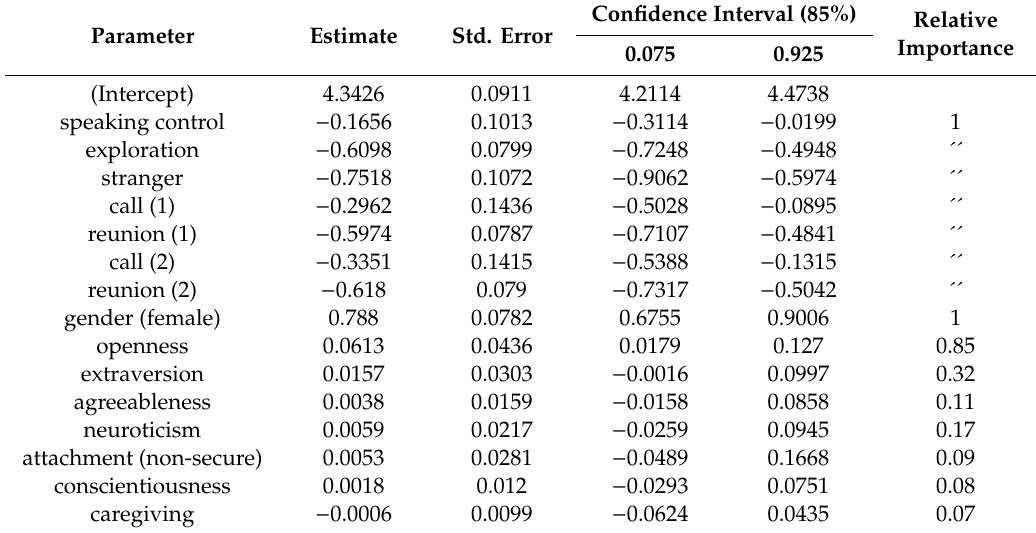
Table 2. Model averaged coe ffi cients for frequency range models. Only variables with a minimum relative importance of > 0.8 and a confidence interval not ranging over 0 are taken into consideration for model